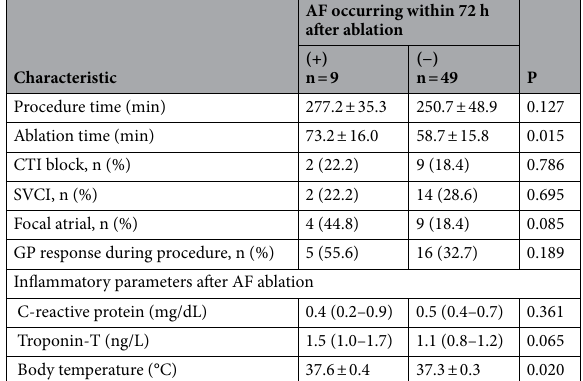
Table 4. Procedural characteristics in patients with and without AF recurrence within 72 h after ablation. AF atrial fibrillation, CTI cavotricuspid isthmus, SVCI superior vena cava isolation, GP ganglionated plexus.